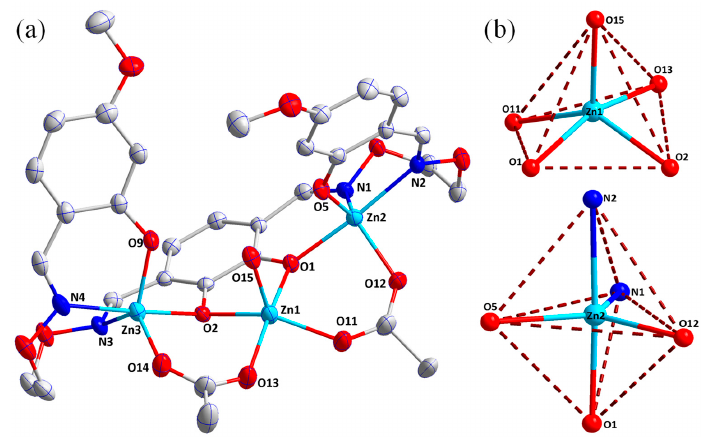
Figure 3. ( a ) Representation of the Zn II coordination compound structure; ( b ) The coordination polyhedra of Zn1 and Zn2 centers.